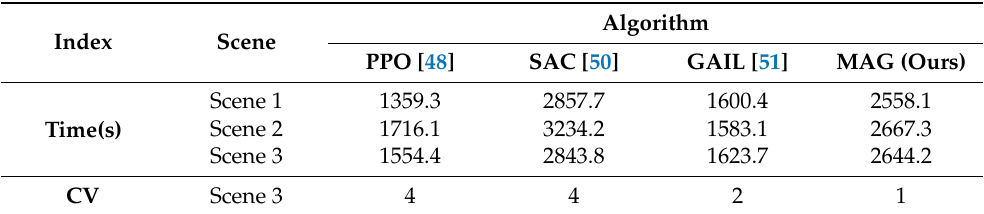
Table 2. Training time and collision violations (CV) using PPO, SAC, GAIL, and MAG in the process of AUV target-tracking in Scenes 1, 2, and